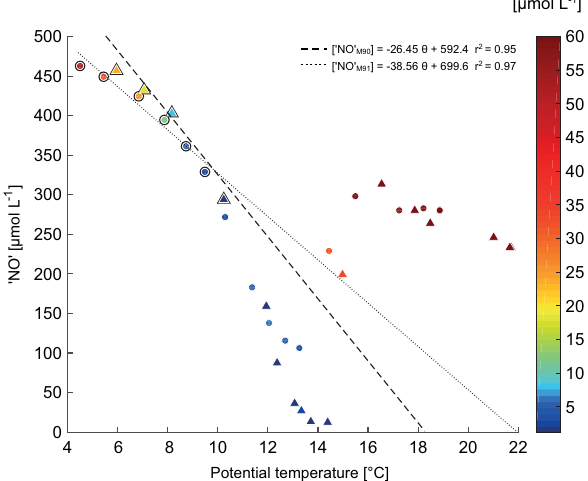
Figure 7. “NO” vs. potential temperature ( θ) for stations located at the centre of eddy A during M90 (November 2012; circles) and M91 (December 2012; triangles). The color bar represents the O 2 con- centrations (scale has been truncated at 60µmolL − 1 ) . “NO” values from non-denitrifying waters (O 2 >5µmolL − 1 ) are highlighted in black and were used for the linear least-squares